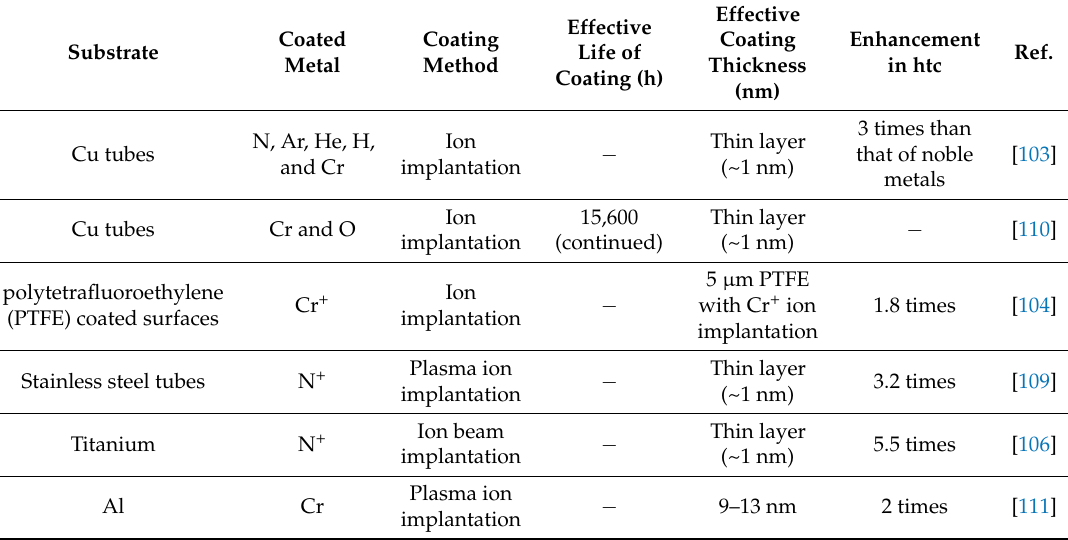
Table 2. Steam condensation enhancements by ion